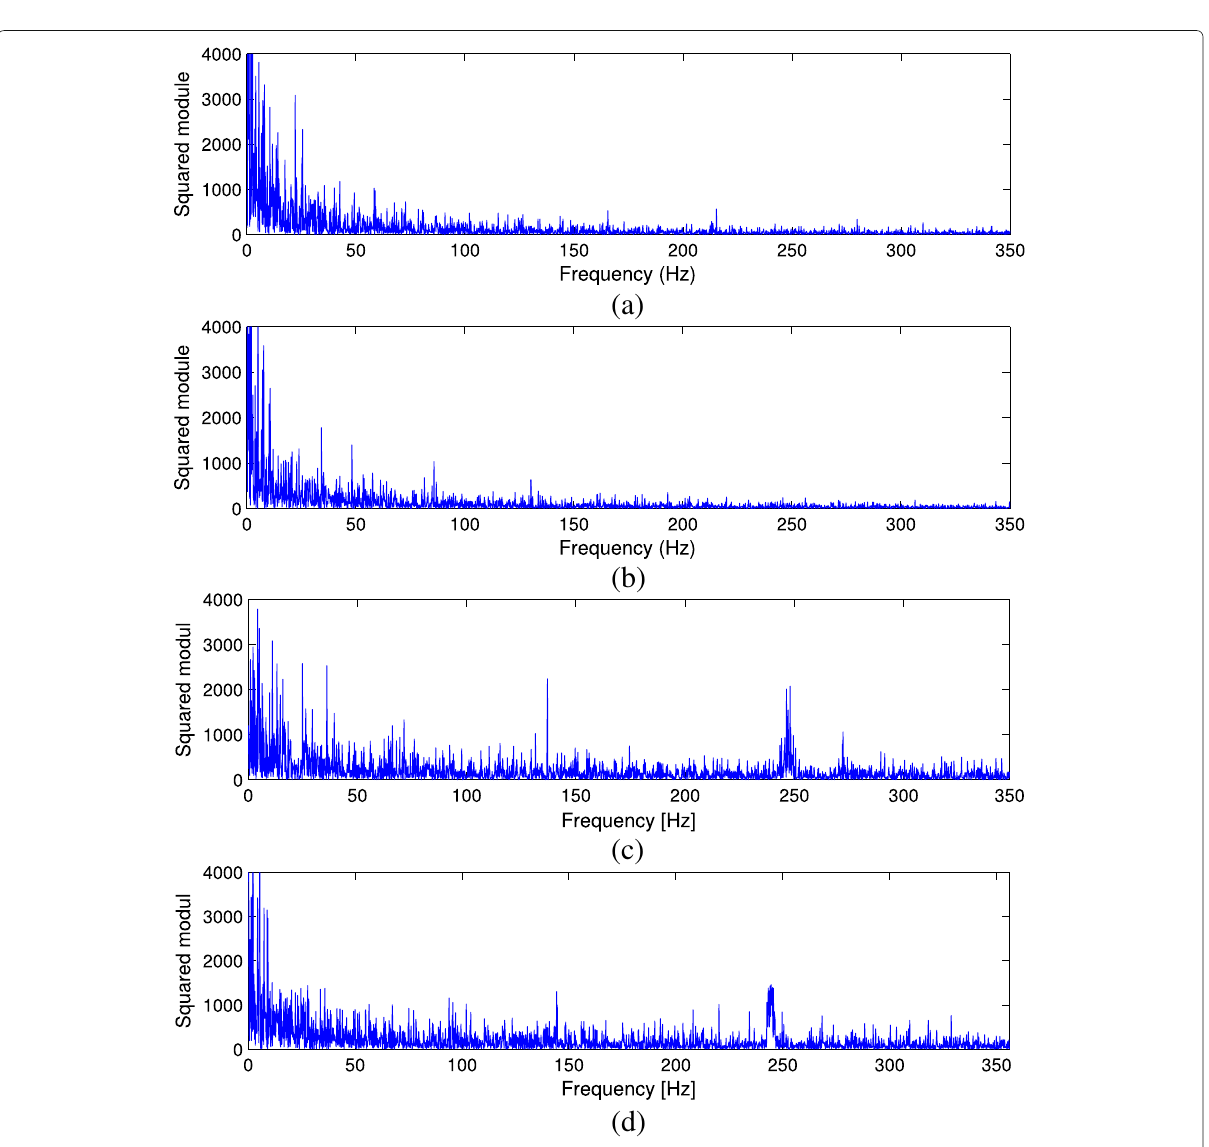
Fig. 2 Measured signal energy spectral density of a valid and b faulty electrode and signal energy spectral density with added stationary component for c valid and d faulty